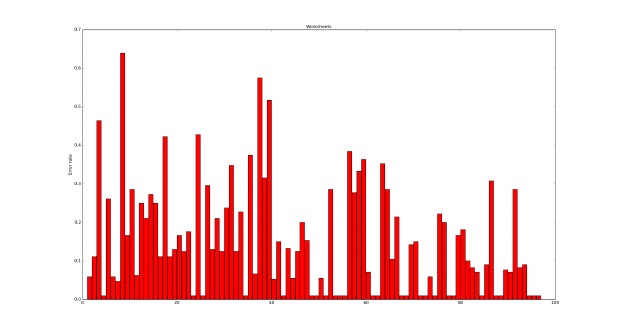
Figure 16. Variations in the error rate for the various learning